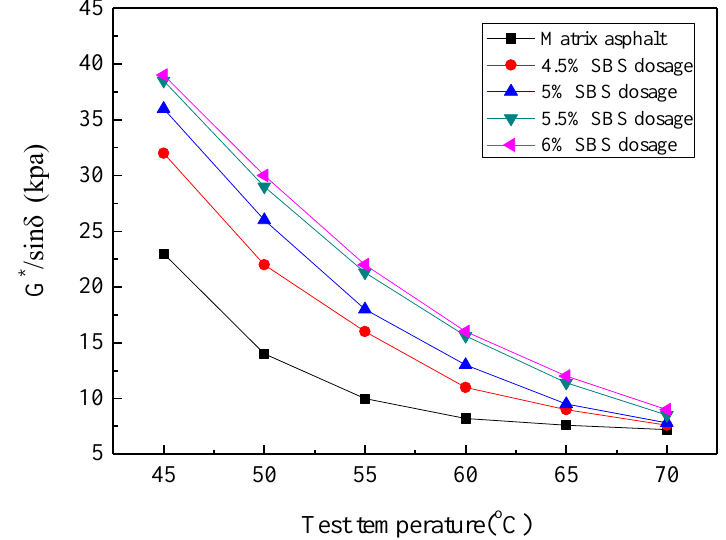
Figure 4. Rutting resistance factor of matrix asphalt and SBS modified asphalt at different 167 temperatures. 168